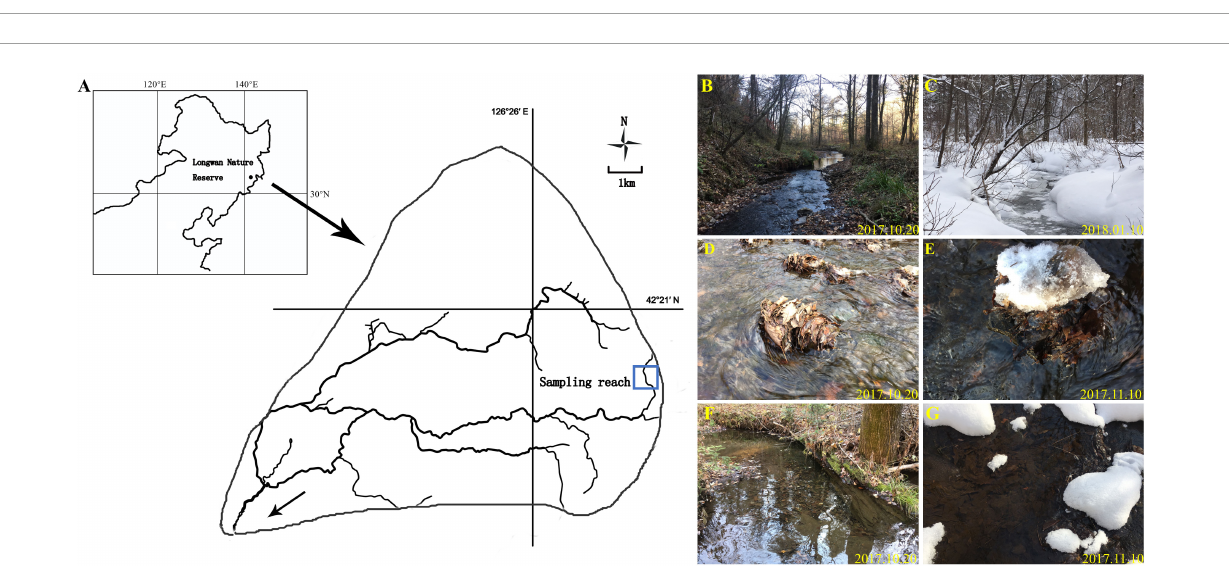
FIGURE2 Location of sampling reach (A) ; sampling reach with sequence of riffles and pools in the autumn (B) ; sampling reach in the winter (C) ; riffle litter in the autumn (D) ; riffle litter in the winter (E) ; pool litter in the autumn (F) ; pool litter in the winter (G)